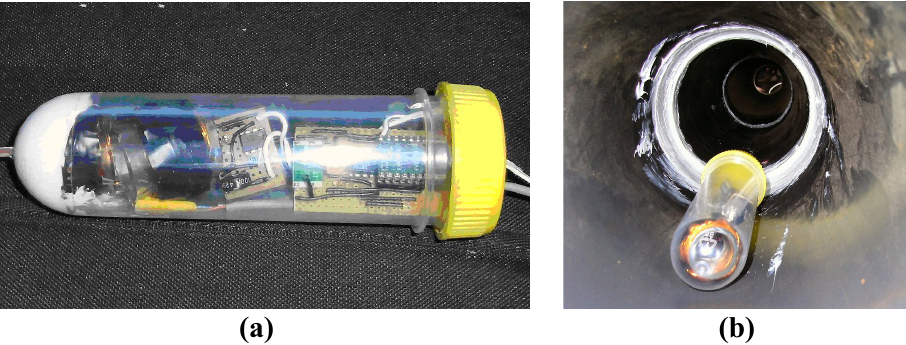
Figure 4. Smart Pig device (a) prior to insertion into the smart pipe demonstrator unit